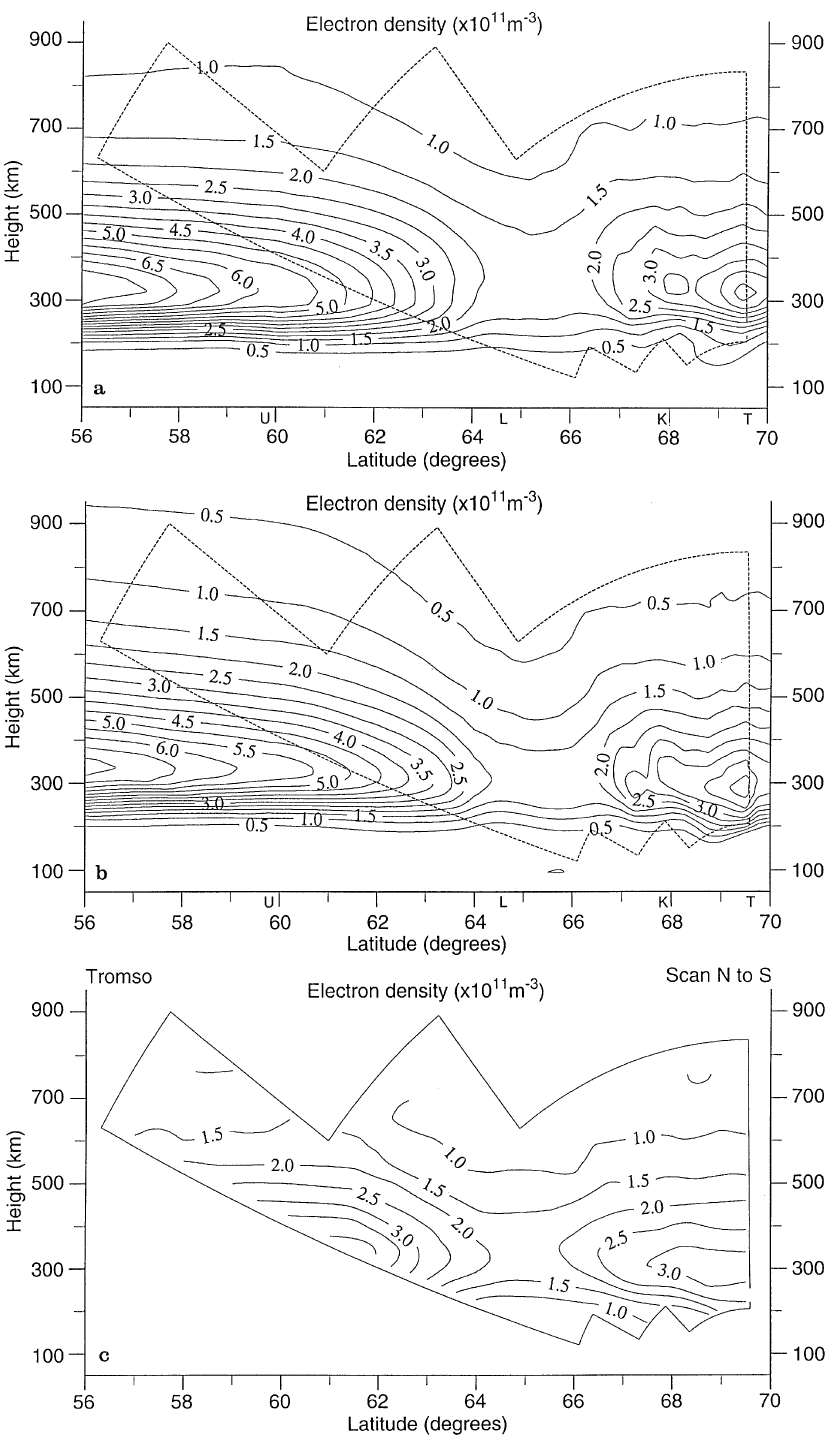
Fig. 3. a Tomographic image of electron density for a satellite pass at 1818 UT on 23 March 1992 with background ionosphere based on IRI-90 model with ionosonde input (after Kersley et al ., 1993); b tomographic image of electron density for the same pass; background ionosphere based on IRI-90 model incorporating ionosonde input, with topside shape selected from a large data base of normalised topside profiles provided by the Malvern and EISCAT incoherent scatter radars; c electron densities measured by EISCAT using SP-UK-TOMO between 1810 and 1829 UT on 23 March